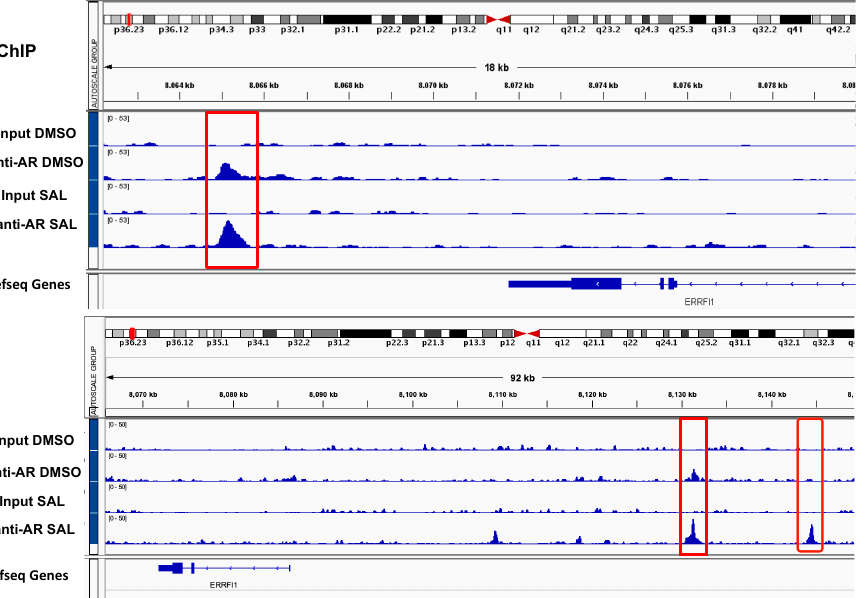
Figure 2. SAL treatment increases, whereas cotreatment with AKTi reduces ERRFI1 mRNA expression and MIG6 protein levels in both LNCaP and C4-2 cells. Cells were treated as indicated for 72 h. ( A , B ) Confirmed regulation of the ERRFI1 using qRT-PCR in both LNCaP ( A ) and C4-2 cells ( B ). ( C ) Protein extracts of cells treated as indicated were used to perform Western blotting for MIG6 detection. The numbers indicate fold change of the band intensities compared to the DMSO control. ( D ) Chromatin immuno-precipitation with subsequent massive parallel sequencing (ChIP-seq) revealed recruitment of AR to the ERRFI1 locus.